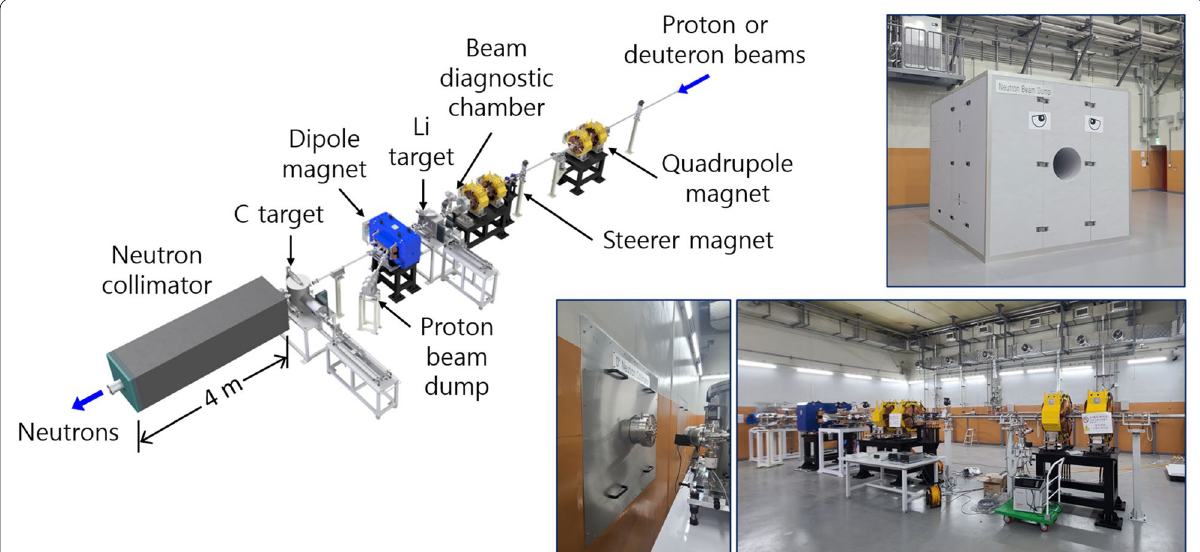
Fig. 13 Schematic of NDPS. The proton or deuteron beams from the SCL3 are transported from the upper-right corner of the schematic on the left figure. The top image shows the neutron beam dump. The two bottom images show part of the 4-m-long neutron collimator (left) and the target room (right)